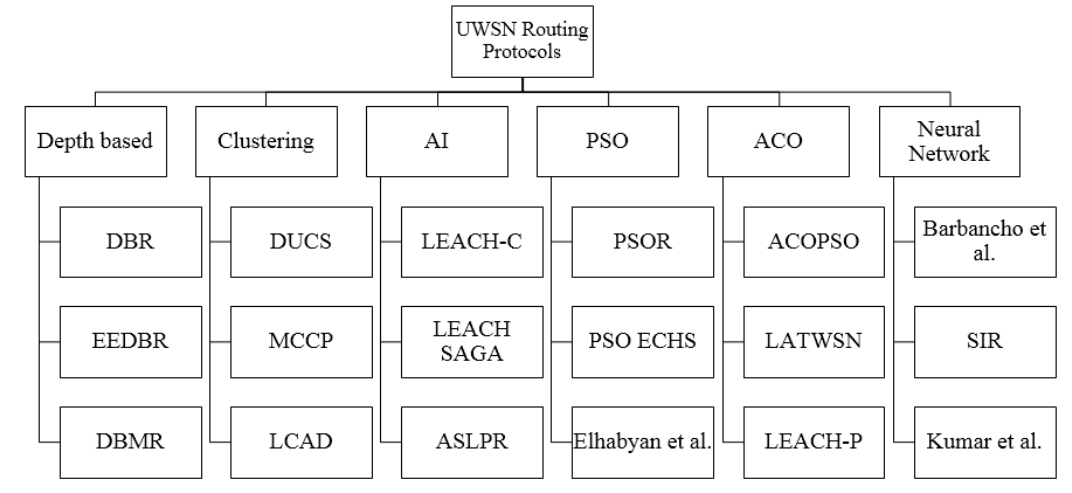
Figure 1. Routing protocols for underwater sensor